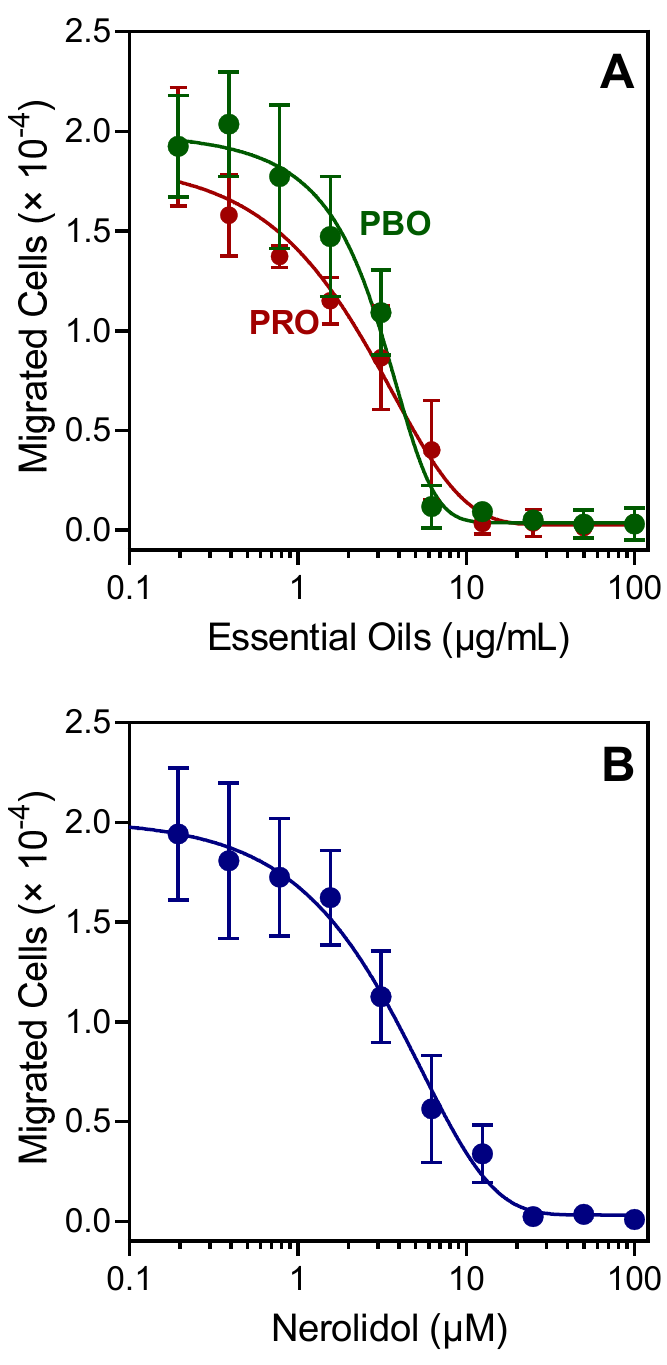
Figure 3. Effect of the PBO, PRO, and nerolidol on human neutrophil chemotaxis. Neutrophils were pretreated with the indicated concentrations of the essential oils ( A ) or nerolidol ( B ), and neutrophil migration toward 1 nM f MLF was measured, as described. The data are from one experiment that is representative of three independent